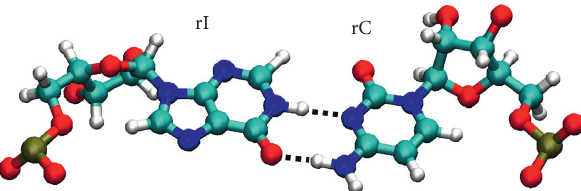
Figure 1: Hybridized poly(I:C) polynucleotide structure with Watson – Crick base pairing. Blue balls: N; green balls: C; gray balls: H; red balls: O; mustard balls: